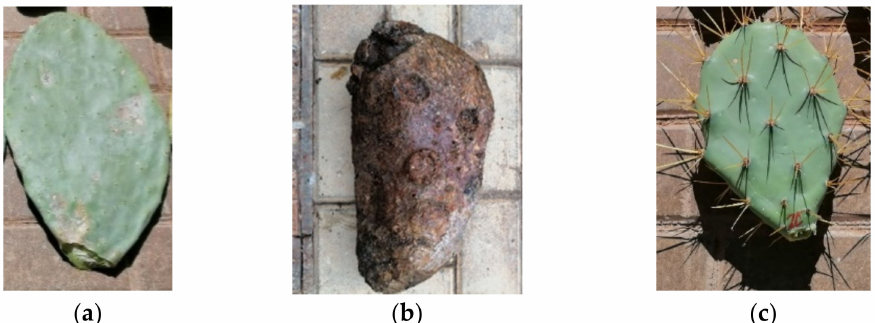
Figure 1. Examples of the cladodes use for the study: ( a ) OM young cladode, ( b ) OM old cladode, ( c ) OD young cladode.